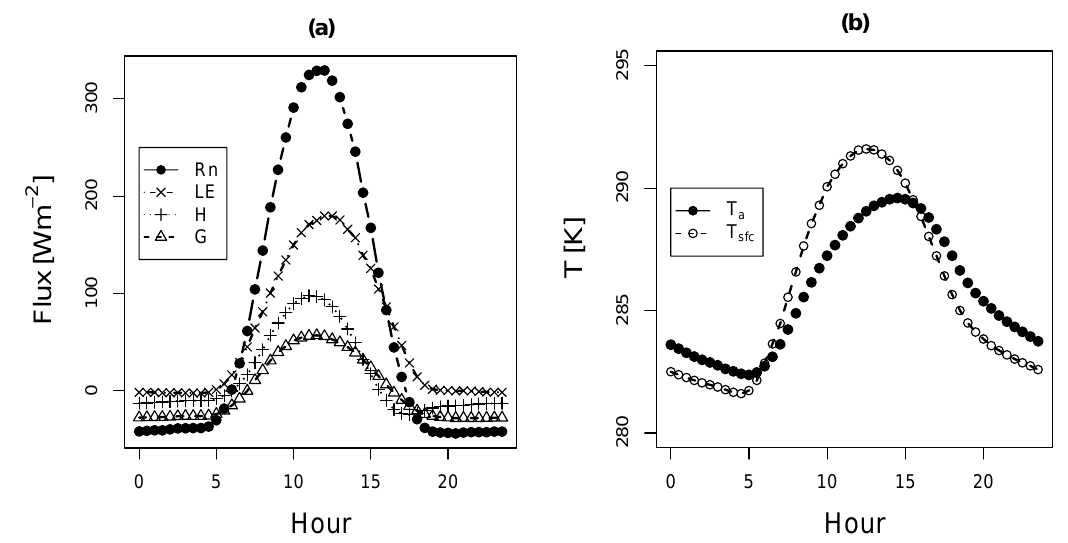
Fig. 2. Mean diurnal (a) surface energy fluxes and (b) surface and air temperatures for the control model